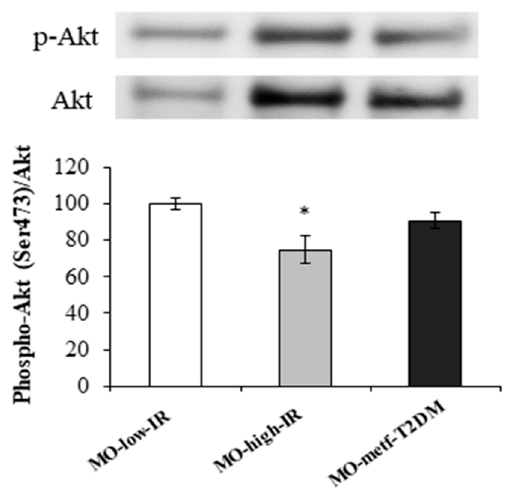
Figure 2. Akt phosphorylation state in jejunum of MO-low-IR ( n = 3), MO-high-IR ( n = 3) and MO-metf-T2DM ( n = 3). Jejunal homogenates were analysed for the phosphorylation of Akt at Ser473. Densitometric analyses of phosphorylation were normalized for Akt. The results are given as mean ± SEM. * p < 0.05: significant differences with regard to MO-low-IR group.